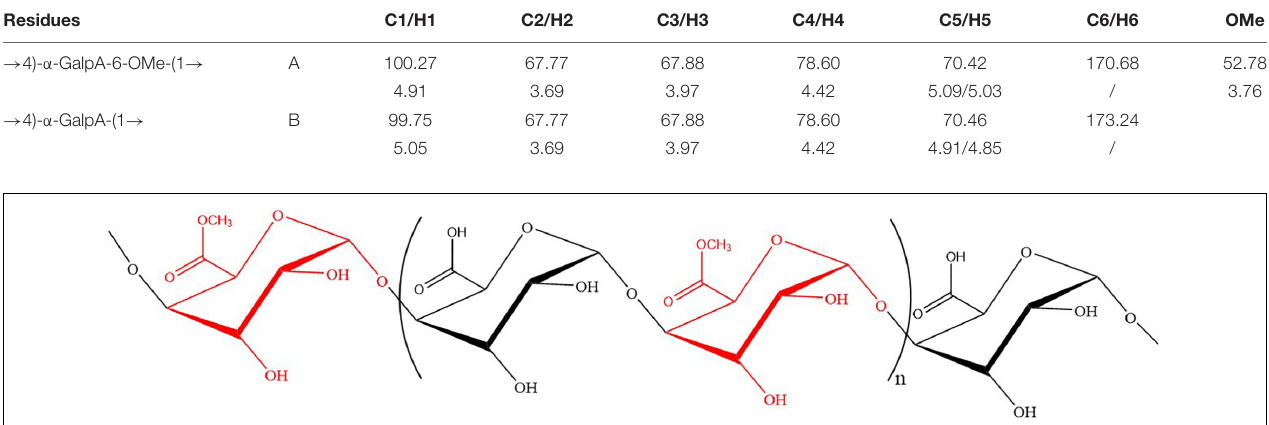
TABLE 3 | The chemical shift of residues in homogalacturonan (HG) backbone. Residues